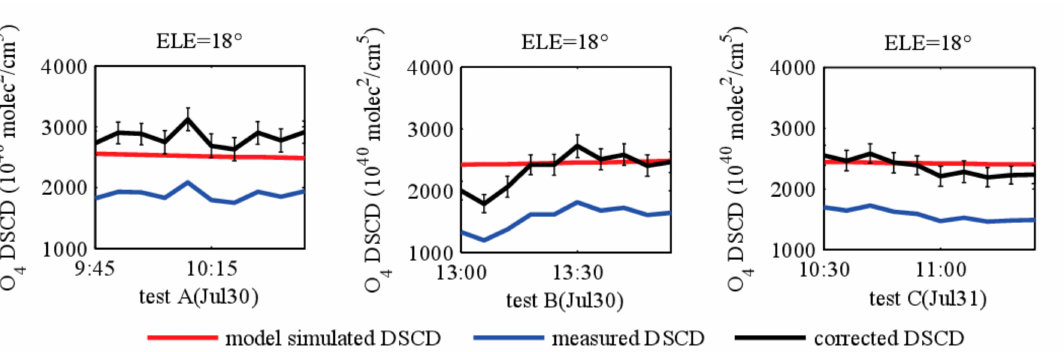
Figure 3. Flow chart for the consistency check.